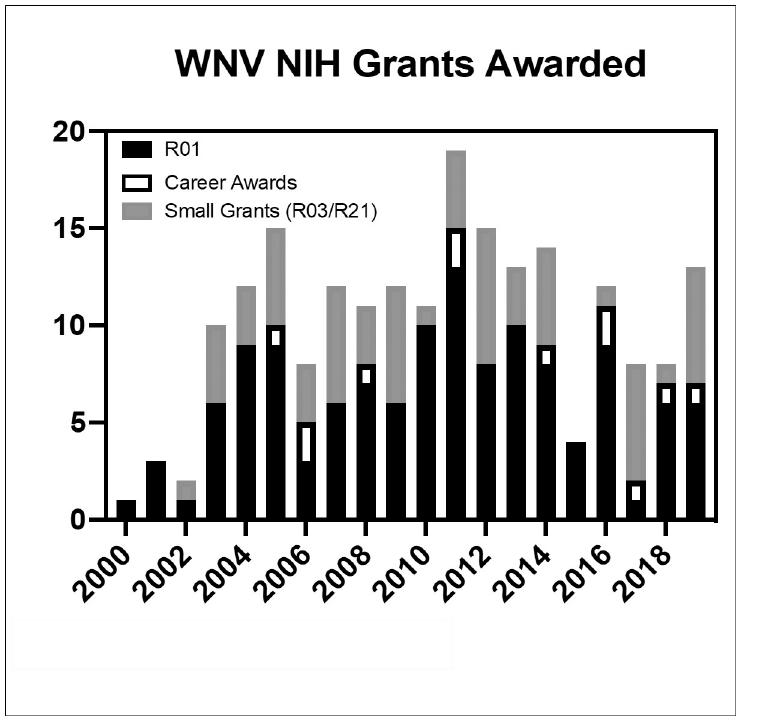
Fig 3. Number of NIH awards granted since 2000. NIH, National Institutes of